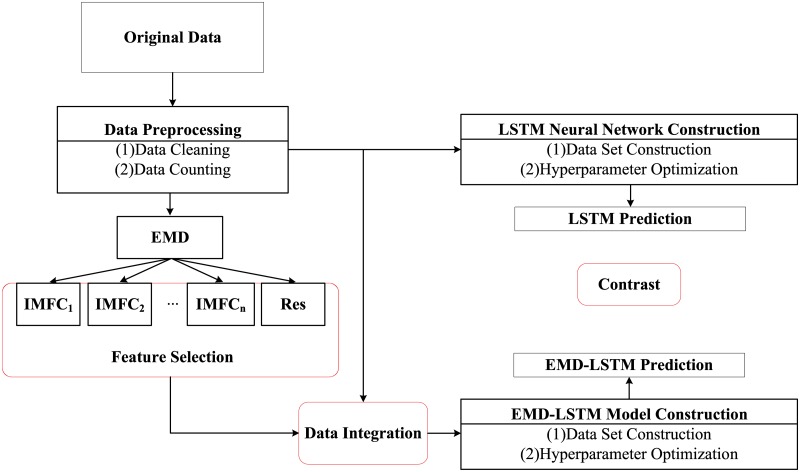
Schematic diagram.